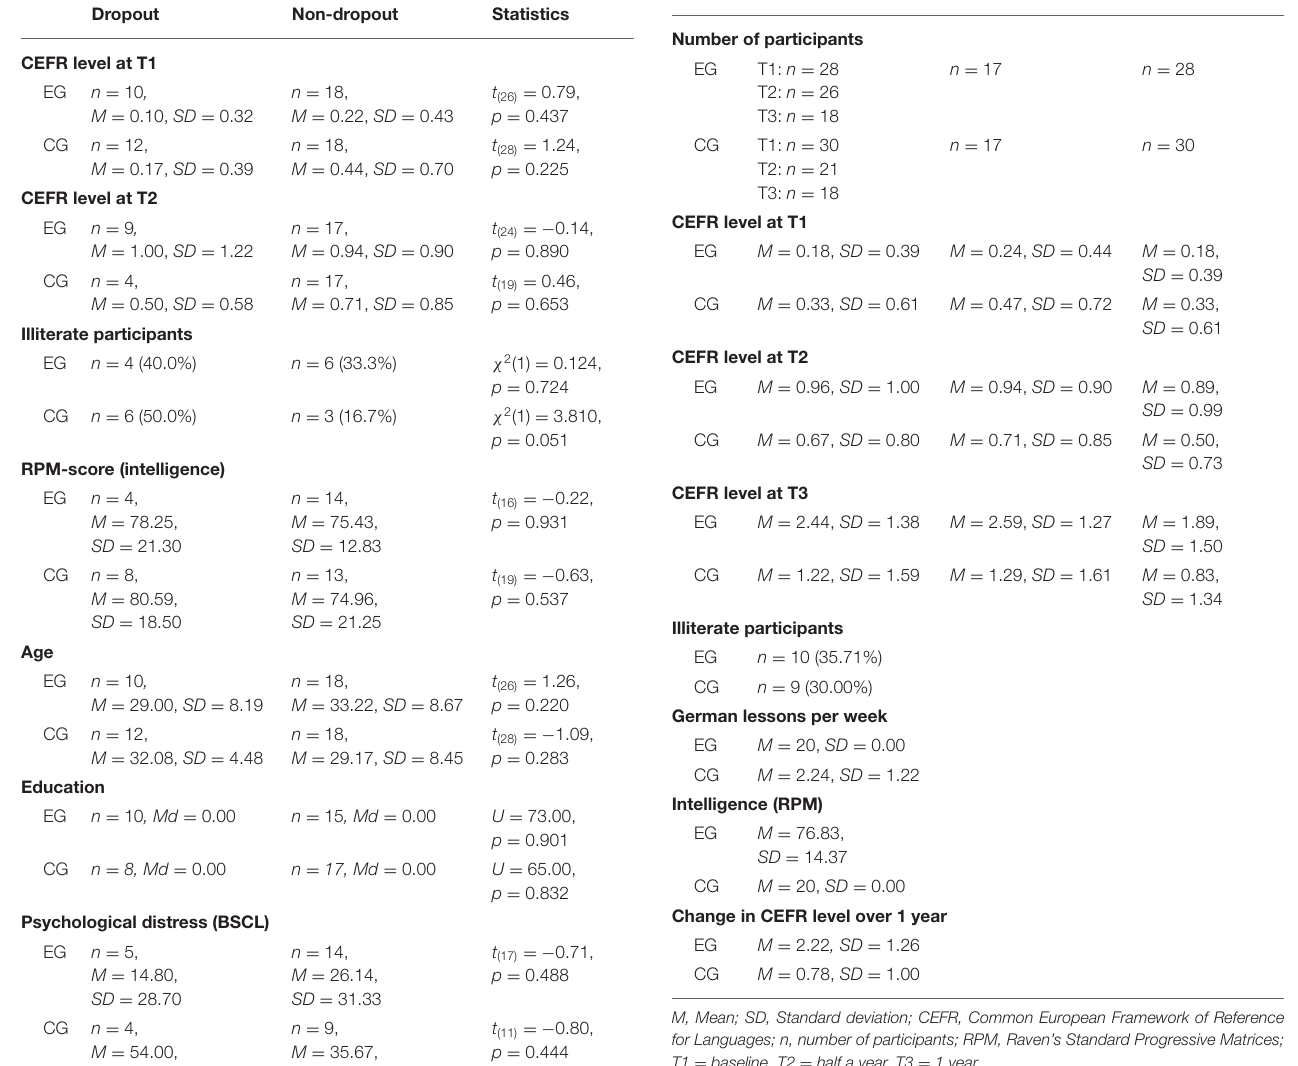
TABLE 5 | Overview of the variables examined in the experimental (EG) and control group (CG).